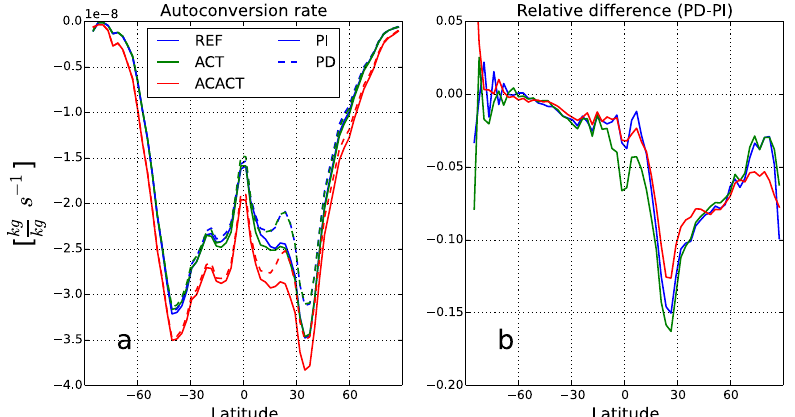
Figure 2. (a) Autoconversion rate for PI and PD conditions in s − 1 at 890hPa and (b) the relative anthropogenic change for each model